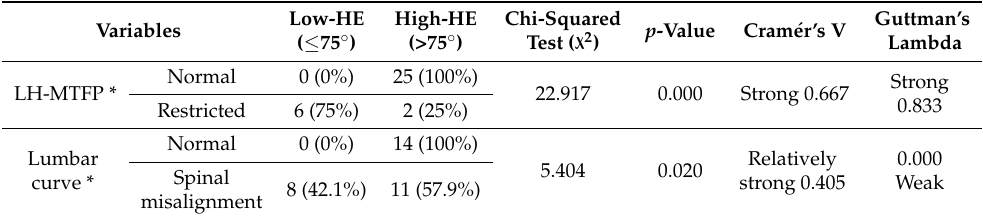
Table 5. Variables associated (expected frequency greater than 5) with high or low hamstring extensibility in female soccer and basketball players.